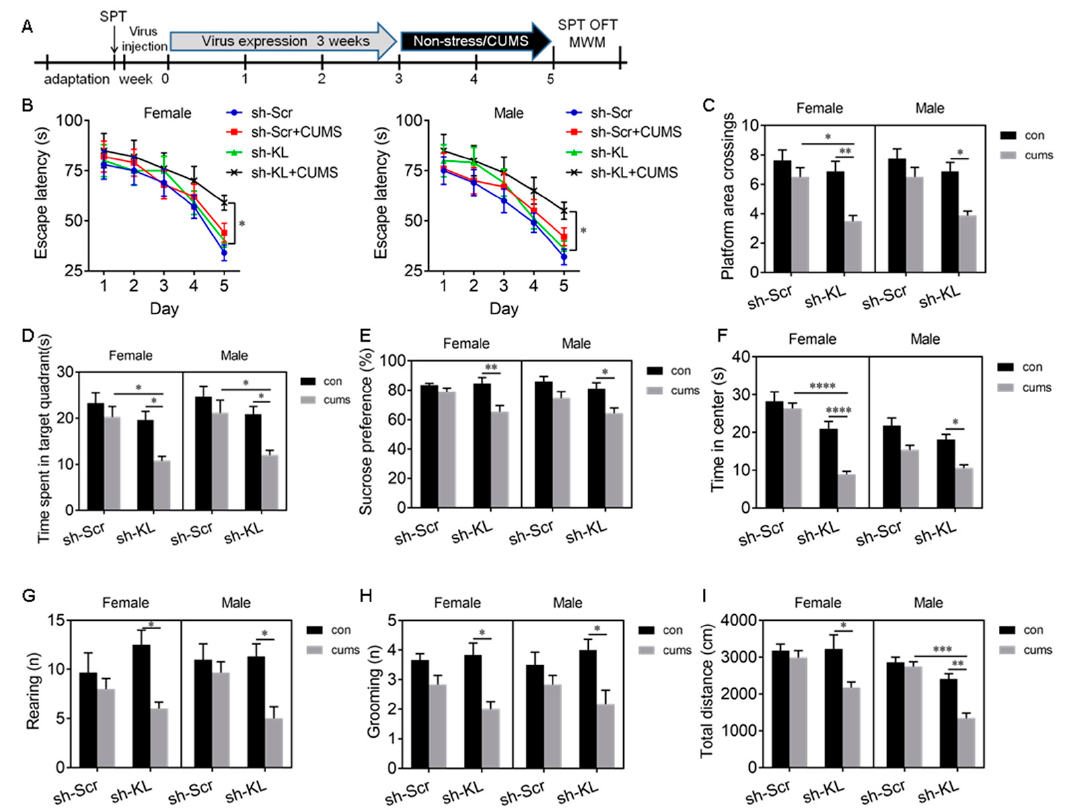
Figure 5. AAV-mediated decrease in KL protein levels increased stress susceptibility and diminished sex differences in spatial learning and memory deficit, anhedonic-like behaviors, and anxiety-like behaviors induced by 2-week CUMS. Experimental design. Sucrose preference test (SPT), open-field test (OFT), and Morris water maze (MWM) test ( A ). In the MWM test, CUMS did not alter the latency to the platform in KL normal rats of both sexes during 5-day training but CUMS caused a decrease in the latency to the platform in KL-KD (knockdown) rats of both sexes on day 5 during training ( B ). CUMS did not alter the number of platform area crossings ( C ) and the time spent in the target quadrant ( D ) in KL normal rats of both sexes. In contrast, in KL-KD rats of both sexes, CUMS decreased the number of platform area crossings ( C ) and the time spent in the target quadrant ( D ) in the MWM test. CUMS caused a decrease in sucrose consumption in the SPT ( E ), a decrease in the time spent in the center of the open field ( F ), a decrease in rearing times ( G ), a decrease in grooming times ( H ), and the total distance traveled ( I ) in the OFT in KL-KD rats of both sexes. Data are shown as the mean ± SEM. ( B ) Three-way repeated-measures ANOVA; ( C – I ) three-way ANOVA followed by Tukey’s test. * p < 0.05, ** p < 0.01, *** p < 0.001, **** p < 0.0001, n = 6–8. sh-KL, KL-shRNA; sh-Scr, control scrambled